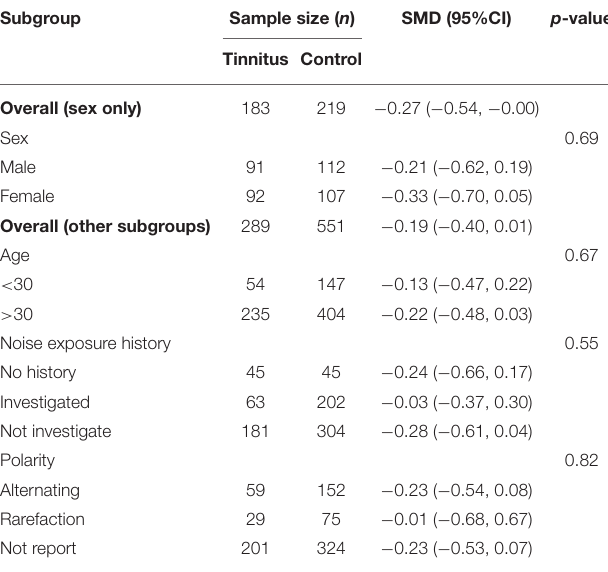
TABLE 5 | Subgroup analysis of the relationship (95% CI) between wave V amplitude and sex, age, noise exposure history, and